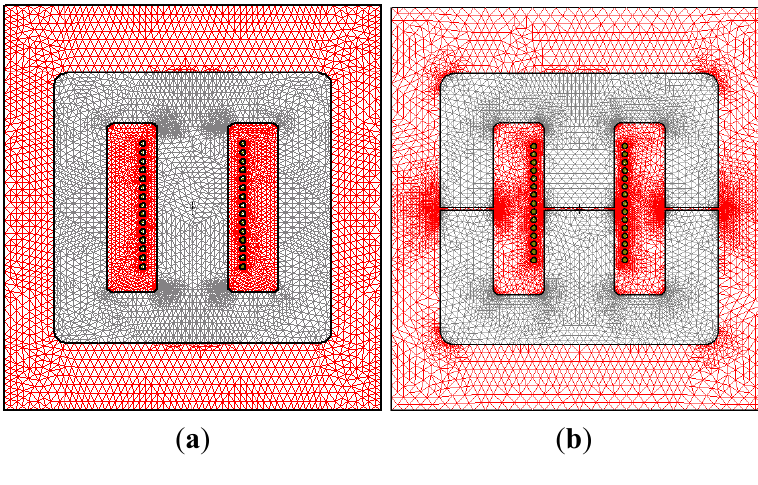
Figure 6. Mesh generated by the simulation program for the domain designed in 2D of the 15 turn-E20/10/5 inductor for τ = 1% and two different values of g : ( a ) g = 0 µm; ( b ) g = 200